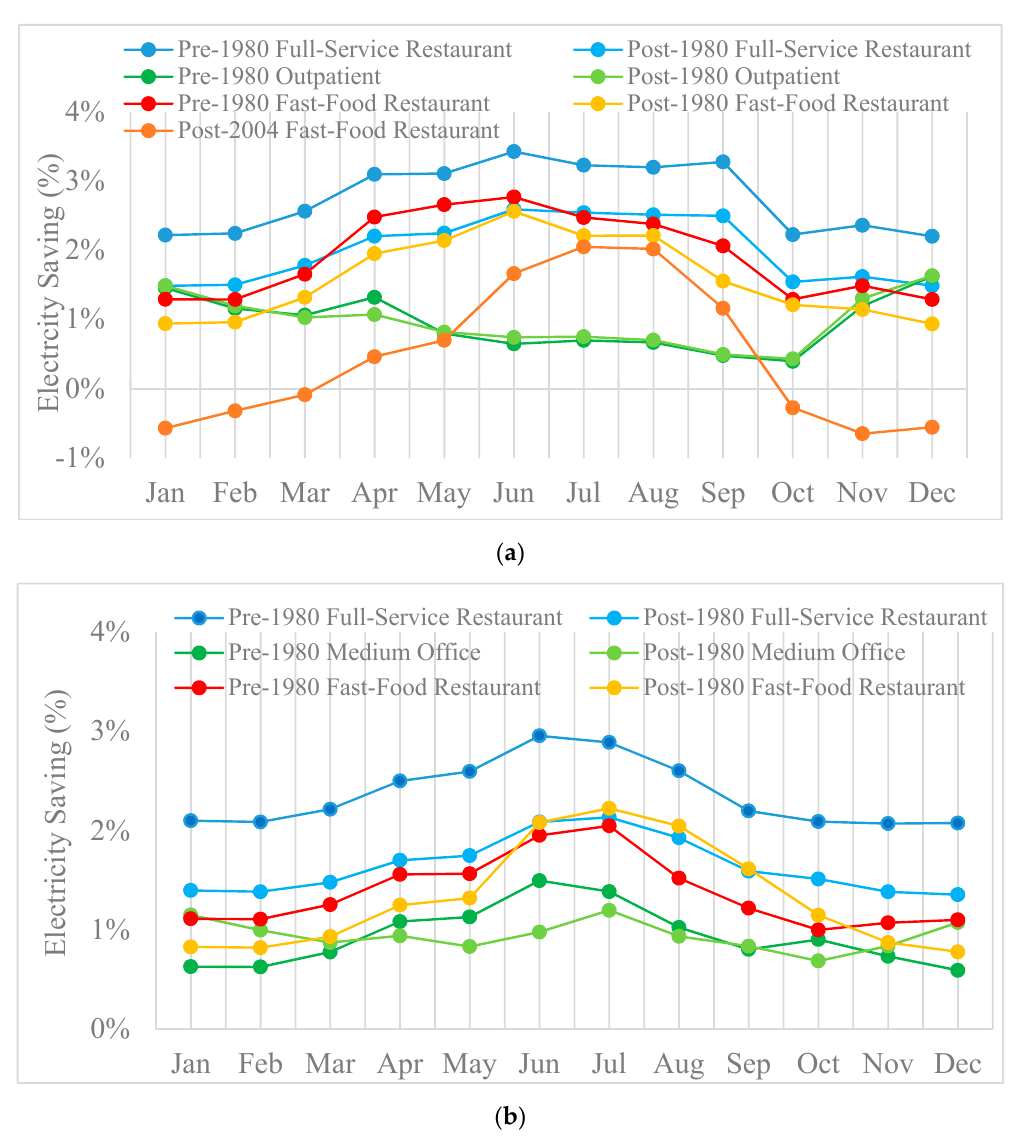
Figure 7. Percentage (%) of monthly electricity savings from green roofs compared with traditional roofs under the A1F1 emission scenario in 2050: ( a ) Glendale; ( b )